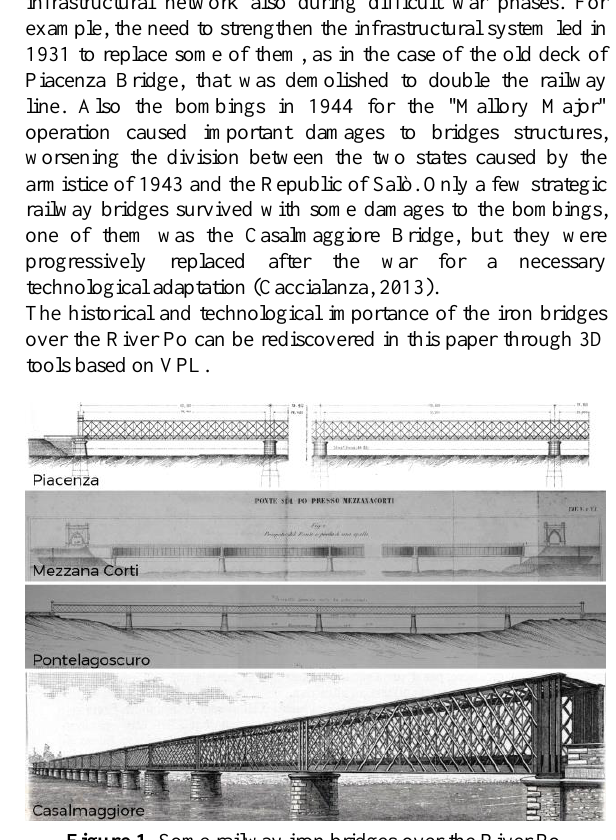
Figure 1 . Some railway iron bridges over the River